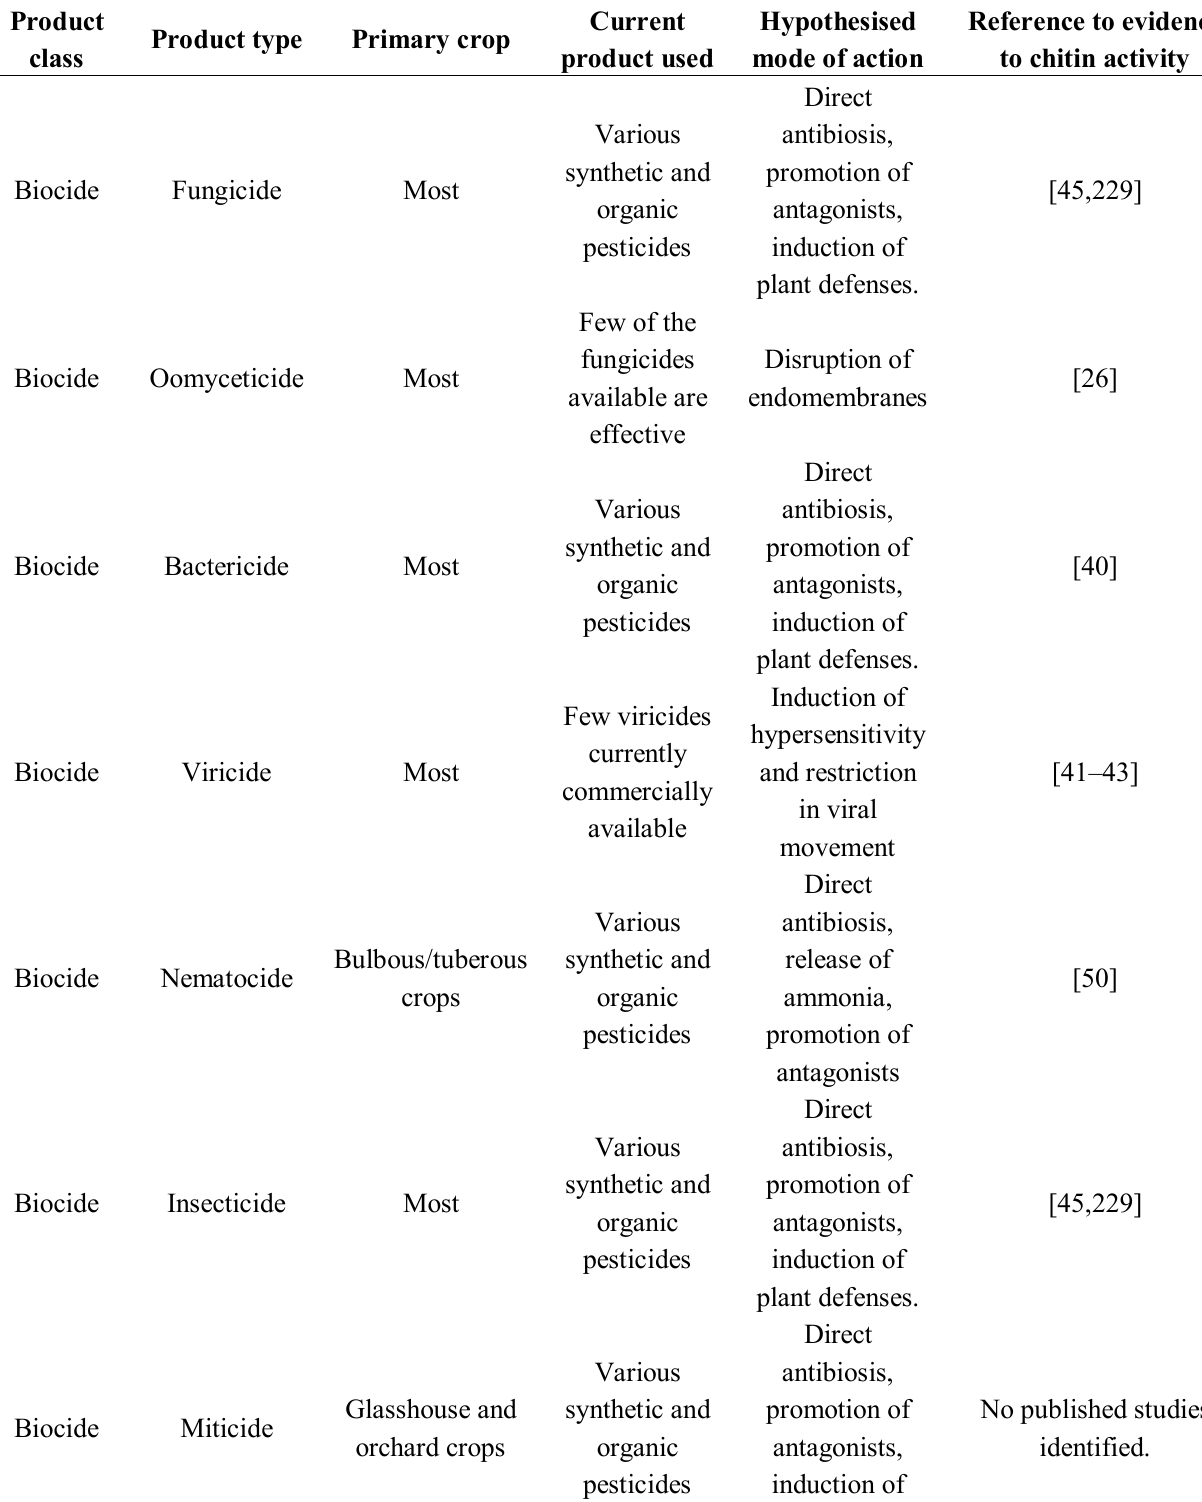
Table 1. Summary of the potential commercial products that chitin and its derivatives could be used for in agriculture and horticulture and their proposed mode of